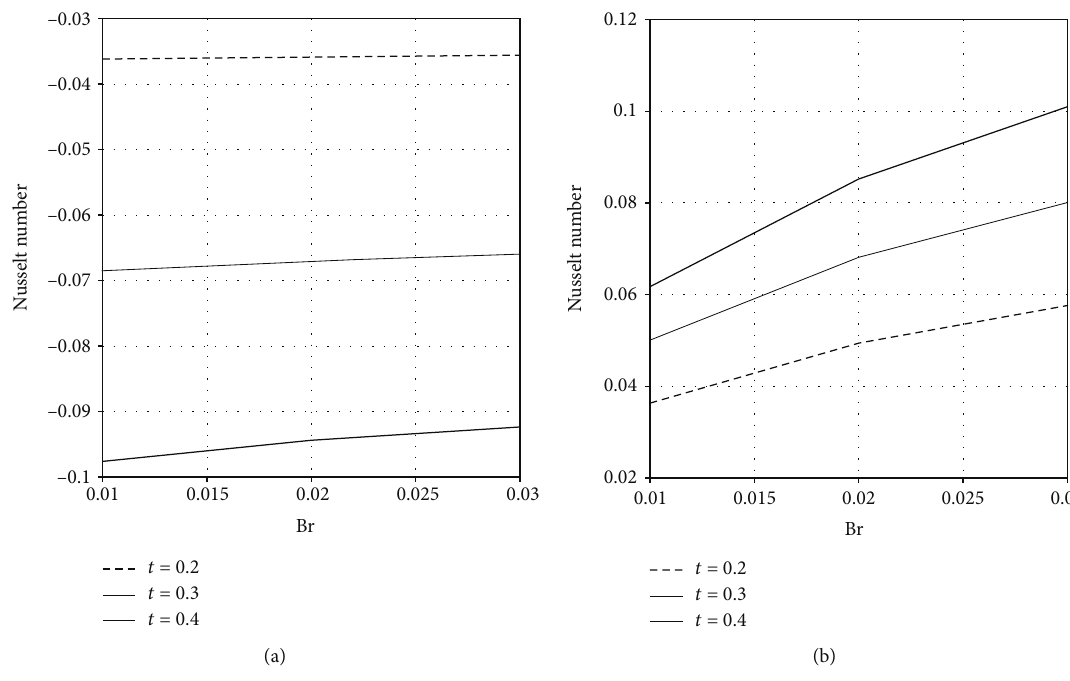
Figure 9: The Nusselt number for Hp in proportion to t